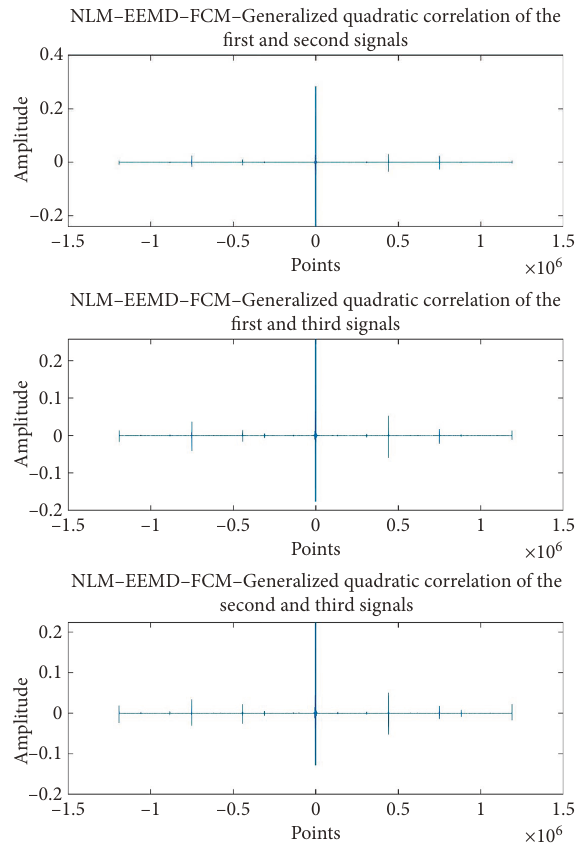
Figure 27: NLM-EEMD-FCM-generalized quadratic